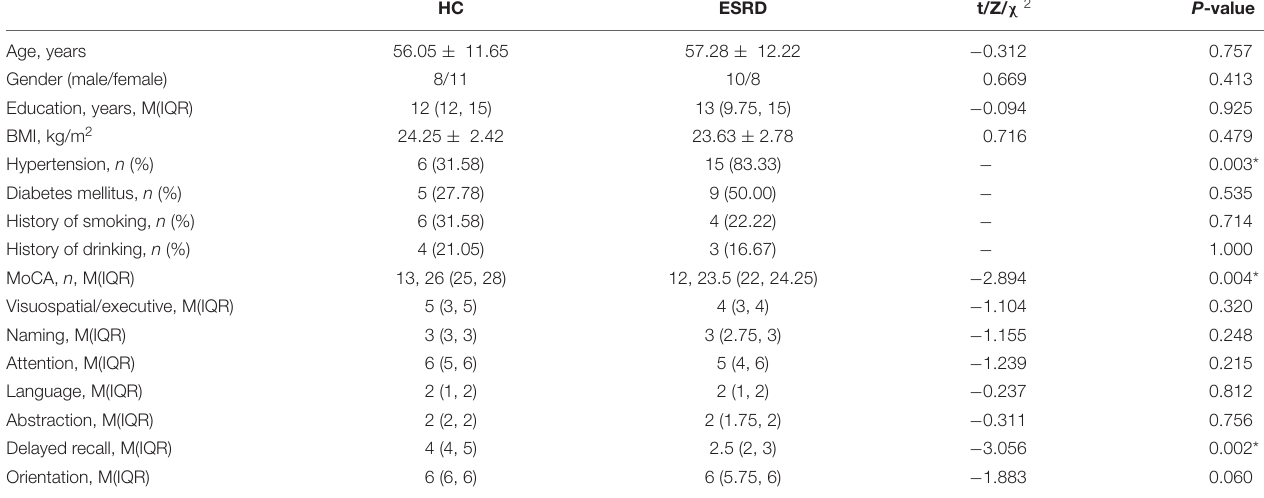
TABLE 1 | Demographic and clinical